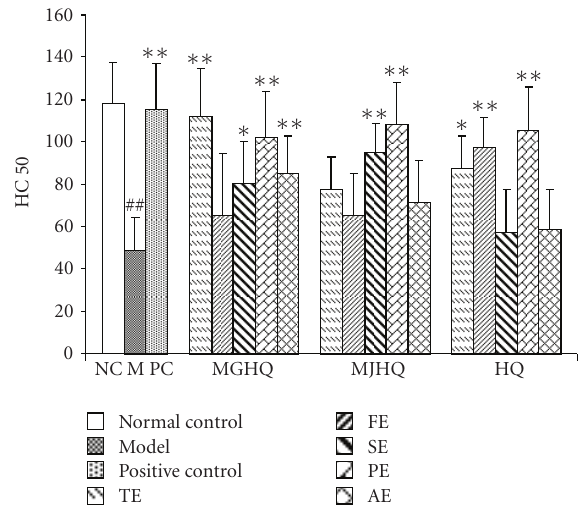
Figure 5: E ff ects of di ff erent extracts treatment on mice serum hemolysin ## P < . 01 and # P < . 05 versus the normal control group. ∗∗ P < . 01 and ∗ P < . 05 versus the model group.